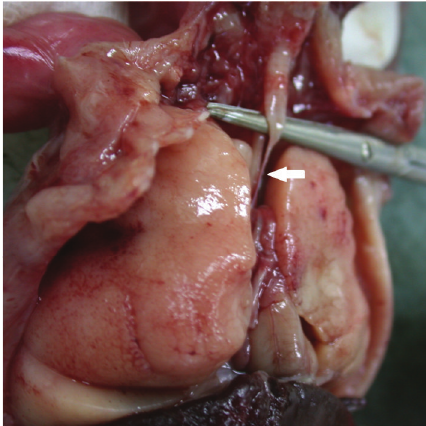
Figure 5: Postmortem autopsy findings of case 2 compatible with tracheal atresia (arrow): voluminous lungs and dilated upper air-